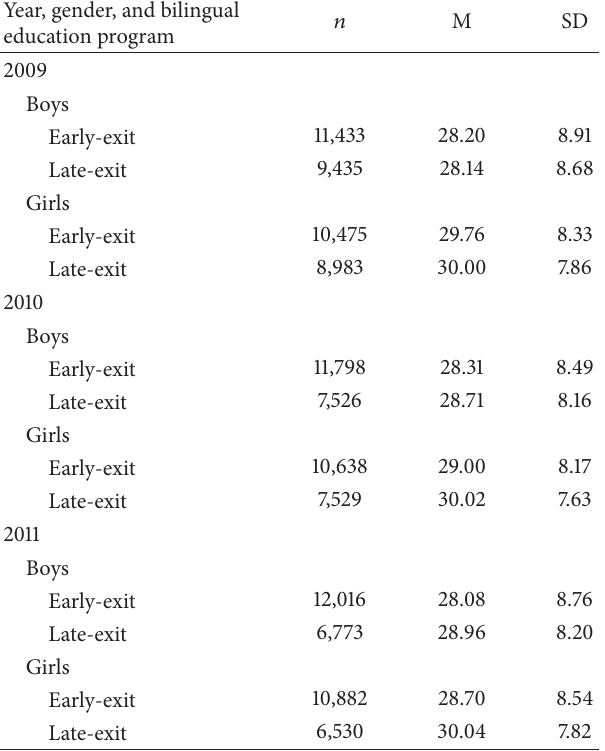
Table 2: Descriptive statistics for the 2009, 2010, and 2011 TAKS Reading scores for grade 4 boys and girls by bilingual education